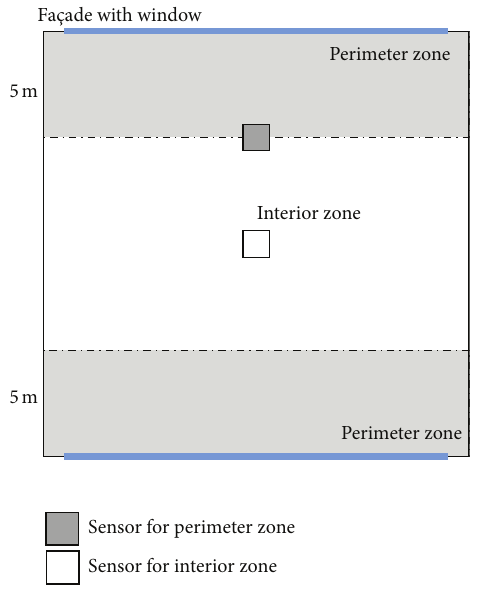
Figure 3: Sensor locations.